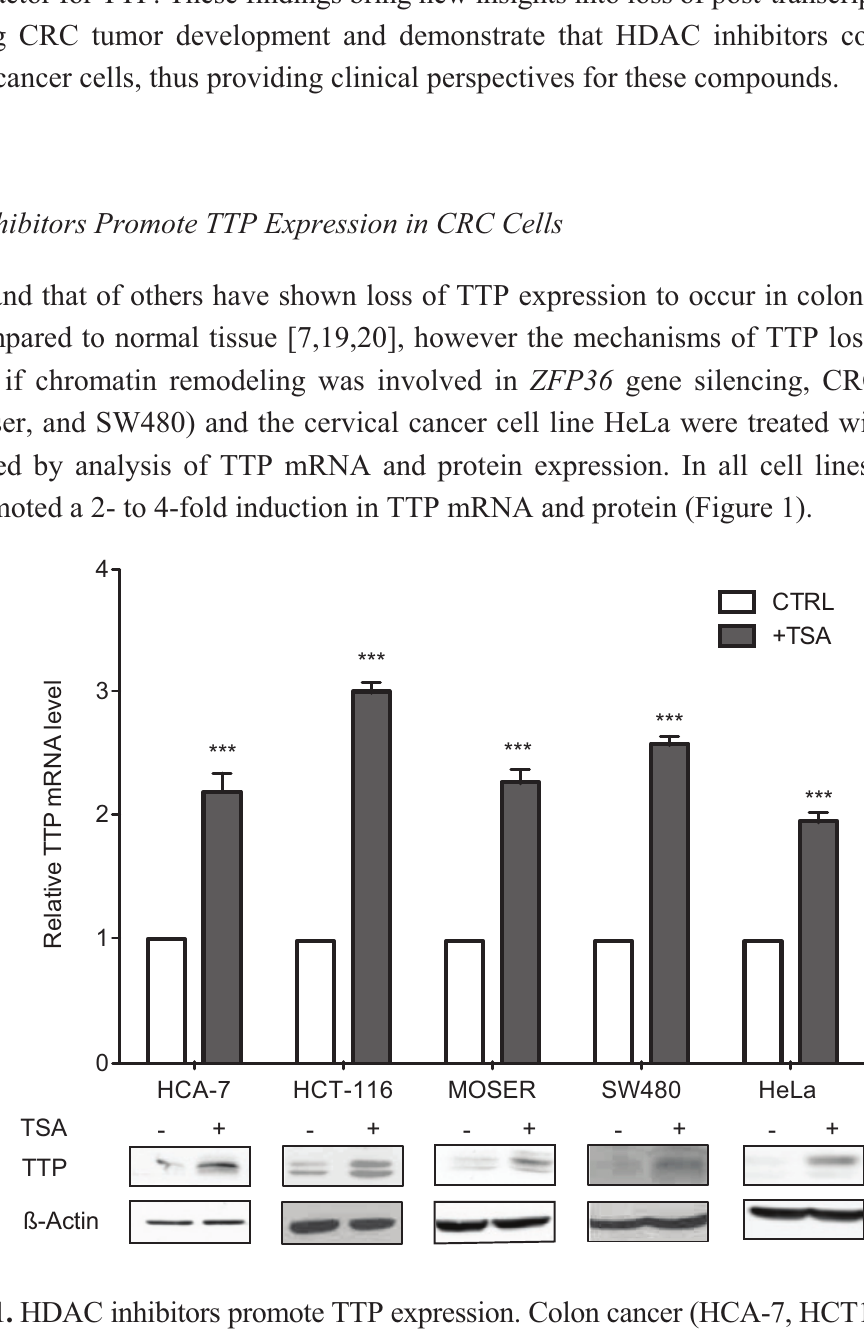
Figure 1. HDAC inhibitors promote TTP expression. Colon cancer (HCA-7, HCT116, Moser, SW480) and HeLa cells treated with 0.4 (cid:3)M TSA for 12 h were examined for changes in TTP mRNA levels ( top ) by qPCR using GAPDH as a loading control and normalized to non-treated cells. TTP protein ( bottom ) expression was analyzed by Western blot using (cid:4)-actin as a loading control. The data represent the mean of three independent experiments (± SD). *** p <